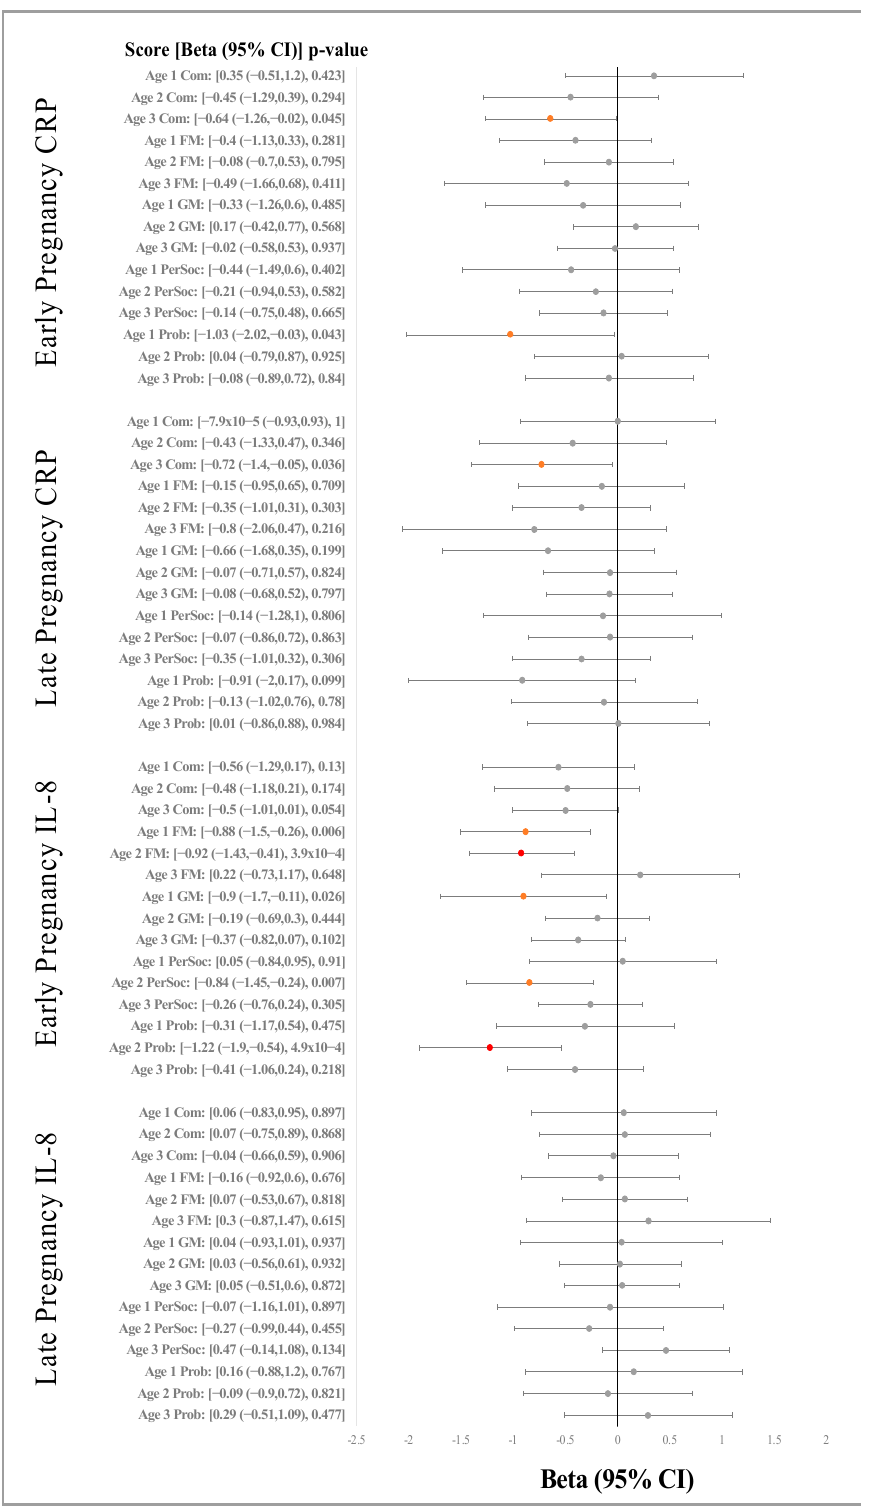
Figure 1. Associations between 1st and 3rd trimester levels of CRP and IL3 with skills scores in the five domains of the ASQ at ages 1, 2, and 3. ASQ score and biomarker levels were both treated as continuous variables. Analyses were adjusted for study site, treatment group, maternal marital status and educational level and gestational age at delivery. Grey: NS; Orange: Significant at p < 0.05; Red: Significant after Benjamini–Hochberg FDR correction; PerSoc: Personal-social score; Comm: Communication score; FM: Fine-Motor score; GM: Gross-Motor score; Prob: Problem-solving